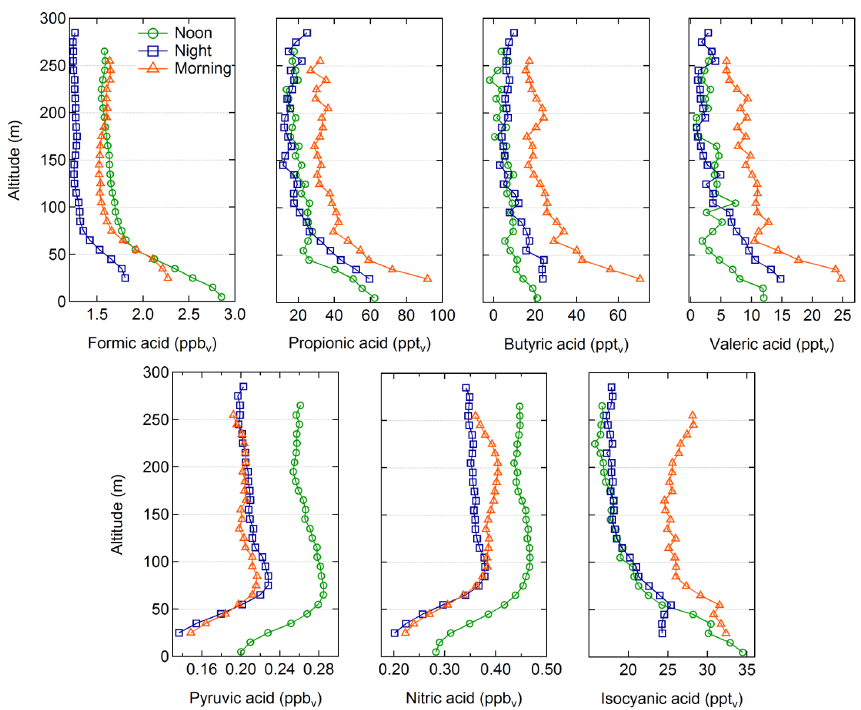
Figure 3. Vertical profiles for all detected gas-phase acids at representative noon, night, and morning periods, showing mixing ratio as a function of altitude. Data are binned by altitude (10m per bin). Data points are means of each bin. Error bars have been removed for clarity, and are included in Fig.